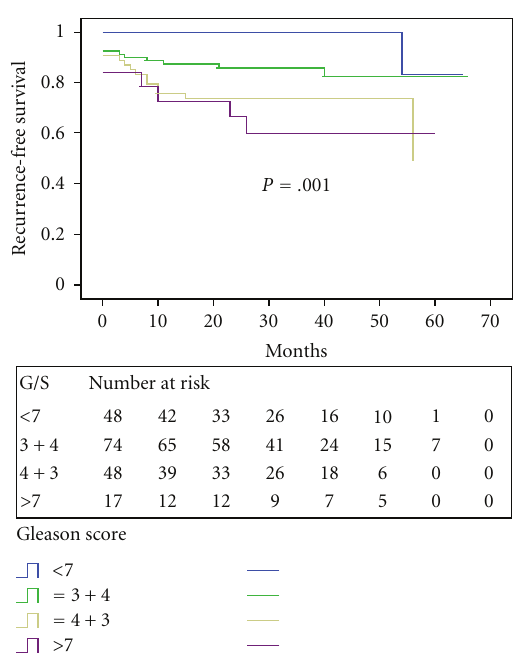
Figure 4: PSA recurrence-free survival stratified by Gleason score.